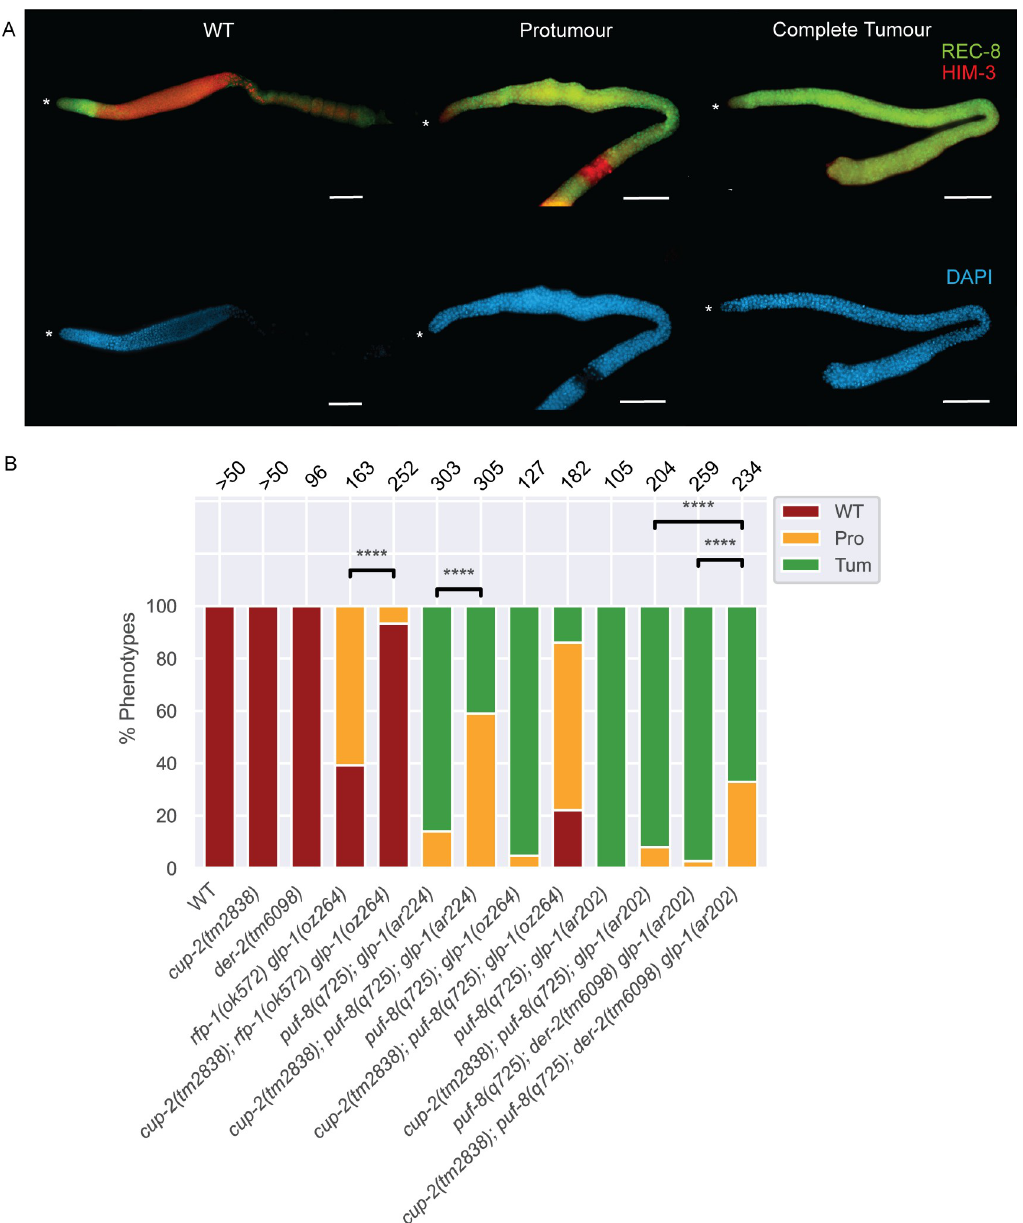
Fig 1. Derlin mutants suppress Notch-dependent tumours in correlation with the strength of GLP-1/Notch signalling. A. Representative images of wild-type (WT), protumourous (Pro) and completely tumourous (Tum) phenotypes as visualized by α -REC-8(green) and α -HIM-3(red) immunostaining. DAPI staining was used to visualize nuclei. Wild-type (WT) is defined as a gonad arm with distal α -REC-8(+) cells followed by α -HIM-3(+) cells and presence of both sperm and oocytes in the proximal arm of the gonad. A protumour is defined as a gonad arm containing both α -REC-8(+) and α -HIM-3(+) cells, but not differentiated sperm and oocytes. Proximal tumourous gonad arms with only sperm but no oocytes were counted as protumours. Gonad arms with mostly only α -REC-8(+) and a few α -HIM-3(+) positive cells were also counted as protumourous. Complete tumour is defined as a gonad arm that contains only α -REC-8(+) cells and no α -HIM-3(+) cells. Both tumourous phenotypes are of the cup-2(tm2838); puf-8(q725); der-2(tm6098) glp-1(ar202) genetic background. Asterisk, distal tip. Scale bar = 20 μ m. B. Quantification of phenotypic analysis of the dissected gonads of the indicated genotypes analyzed by α - REC-8(green) and α -HIM-3(red) immunostaining. In this and all other bar graphs, numbers on the top of the bars indicate the number of gonads analyzed. Chi-square test; ���� = p � 0.0001.